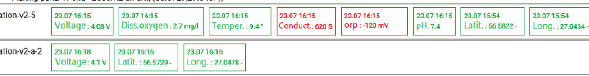
Fig. 8. Dashboard depicting the latest data.